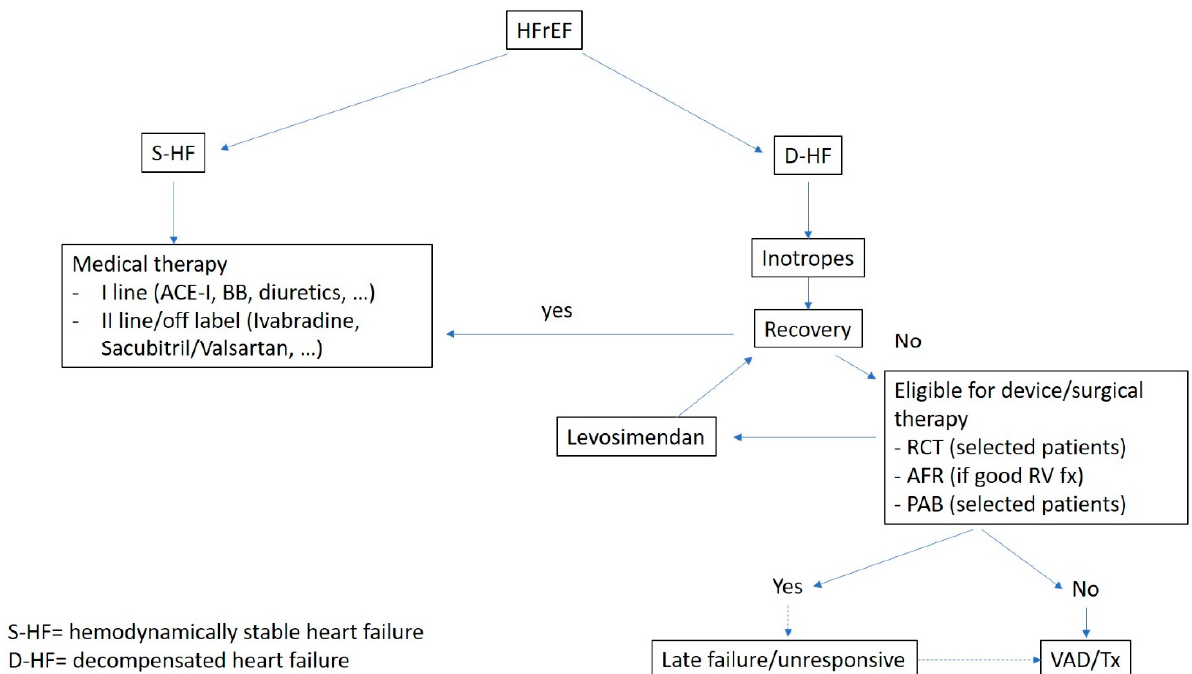
Figure 2. A suggested algorithm of treatment HFrEF.